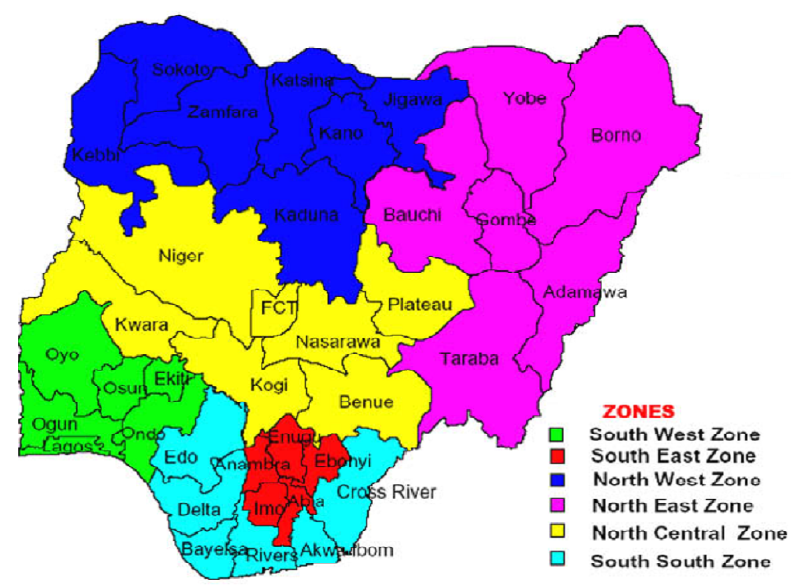
Figure 1. Map of Nigeria showing 36 states (districts) and Federal Capital Territory (FCT) by geopolitical